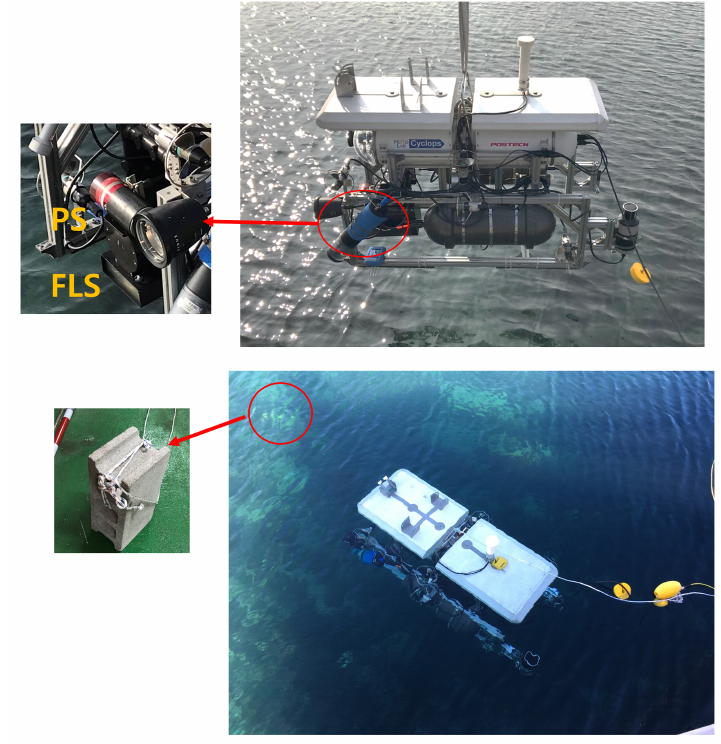
Figure 11. Hovering-type AUV, Cyclops , and the experimental setup in the field